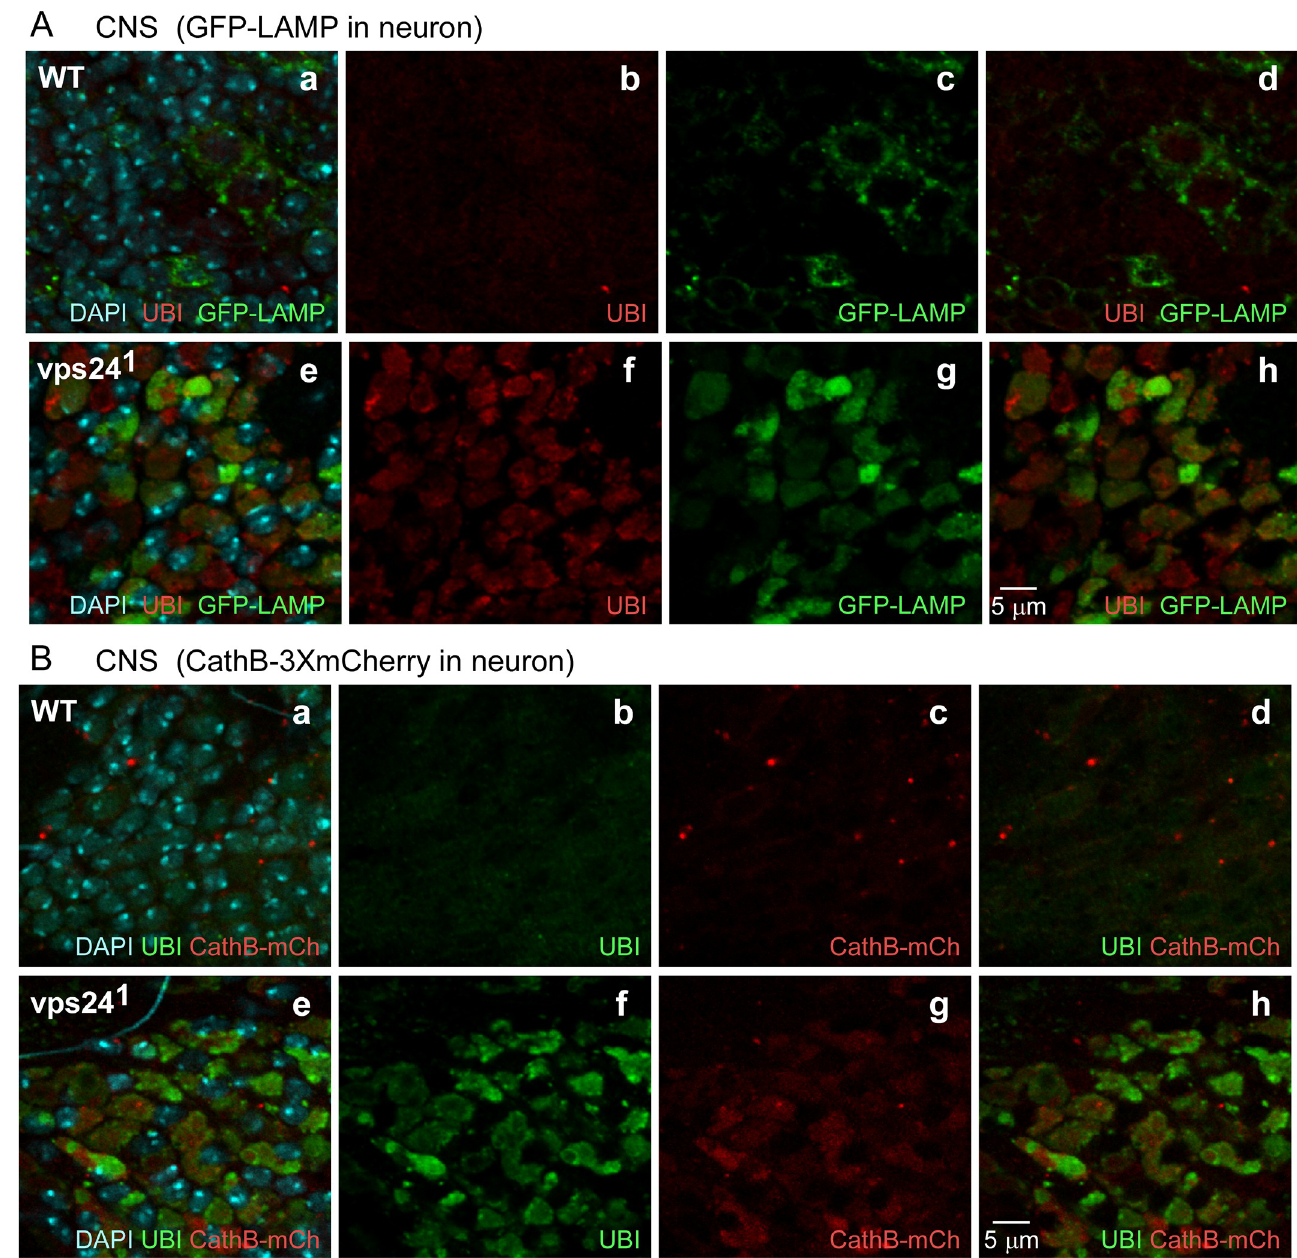
Fig 6. Expansion of lysosomal compartments in neurons of the vps24 mutant. Confocal immunofluorescence and native GFP or mCherry fluorescence images of CNS neurons from WT (a-d) or vps24 mutant (e-h) flies exhibiting neuronal expression of the lysosomal markers, GFP-LAMP (A) or Cathepsin-3xmCherry (CathB-mCh) (B) . Neurons of the vps24 mutant exhibited markedly enlarged ubiquitin-positive lysosomal compartments.